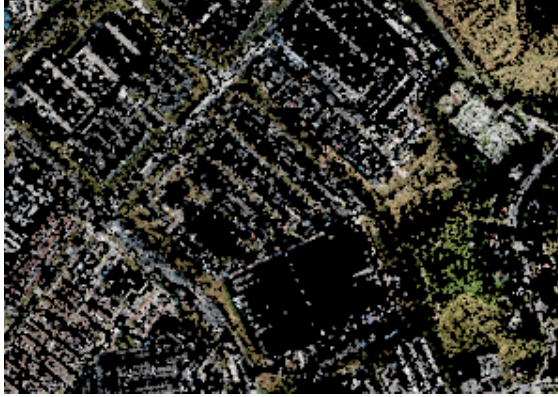
Figure 3: Point cloud of auto-corelated points with color representation taken fromthe photograph